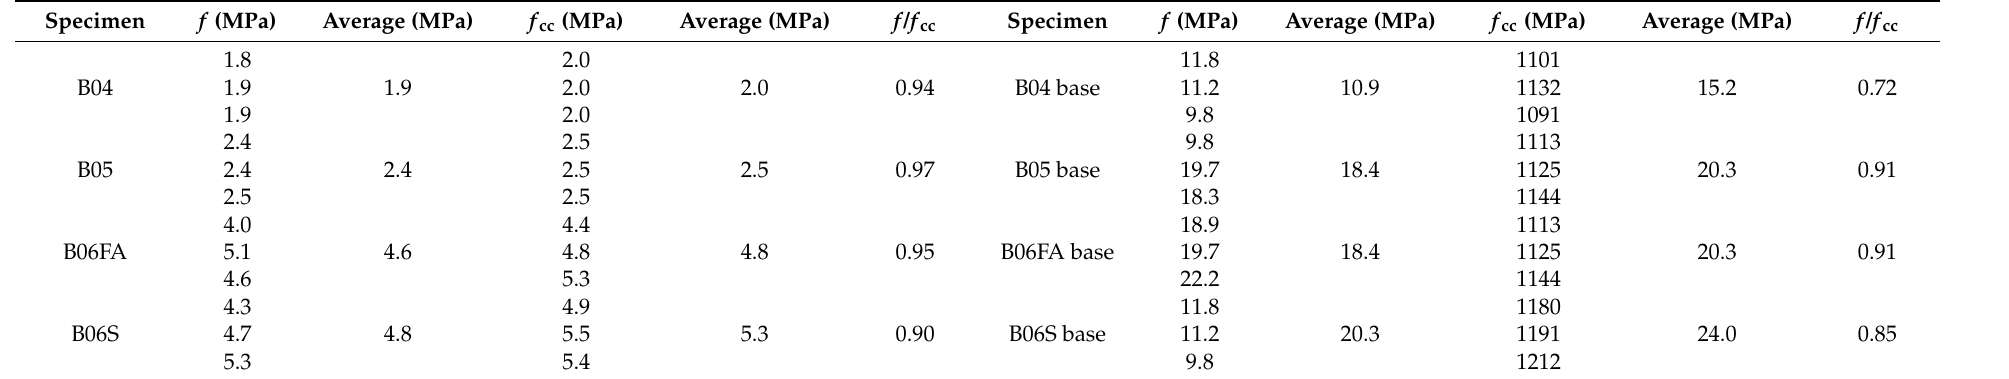
Table 10. Test result of axial compressive strength of AAC and base material.